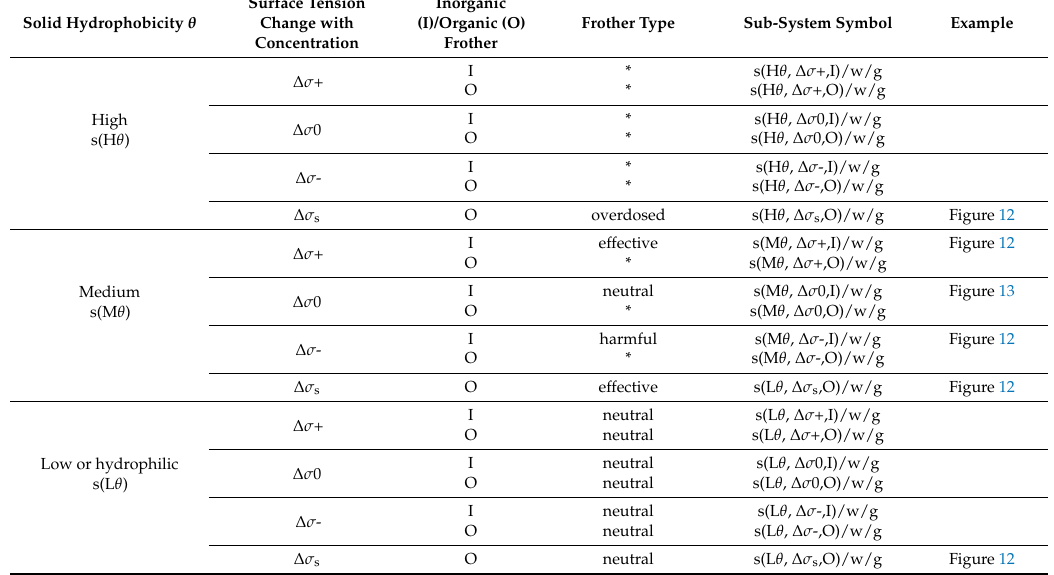
Table 12. Classification of frothers into effective, neutral, harmful and overdosed, based on flotation yield (or maximum yield) change caused by increasing concentration of frother and taking into account particle hydrophobicity θ , frother type (inorganic or organic) and surface tension change (increase ∆ σ +, decrease ∆ σ -, constant ∆ σ 0, significant decrease by surfactant ∆ σ s ) (s: solid; w: water; g: gas). Surface Tension Inorganic (I)/Organic (O) Solid Hydrophobicity θ Change with Concentration